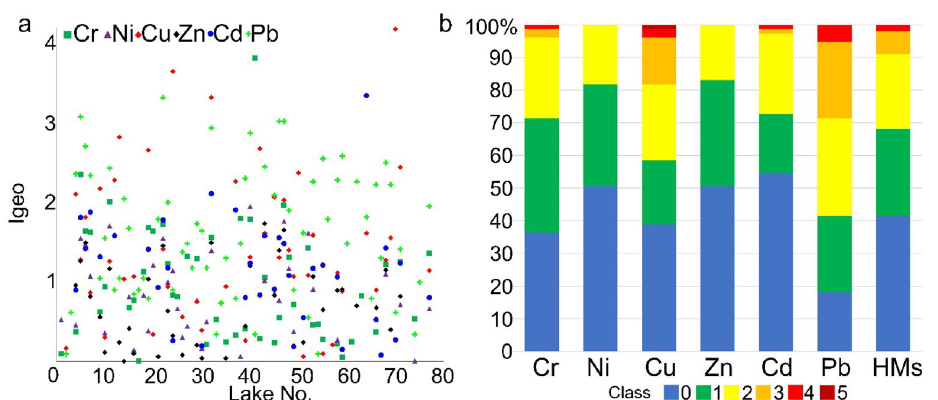
Figure 3. I geo index values higher than 0 ( a ) with the classification of the state of lake sediment pollution ( b